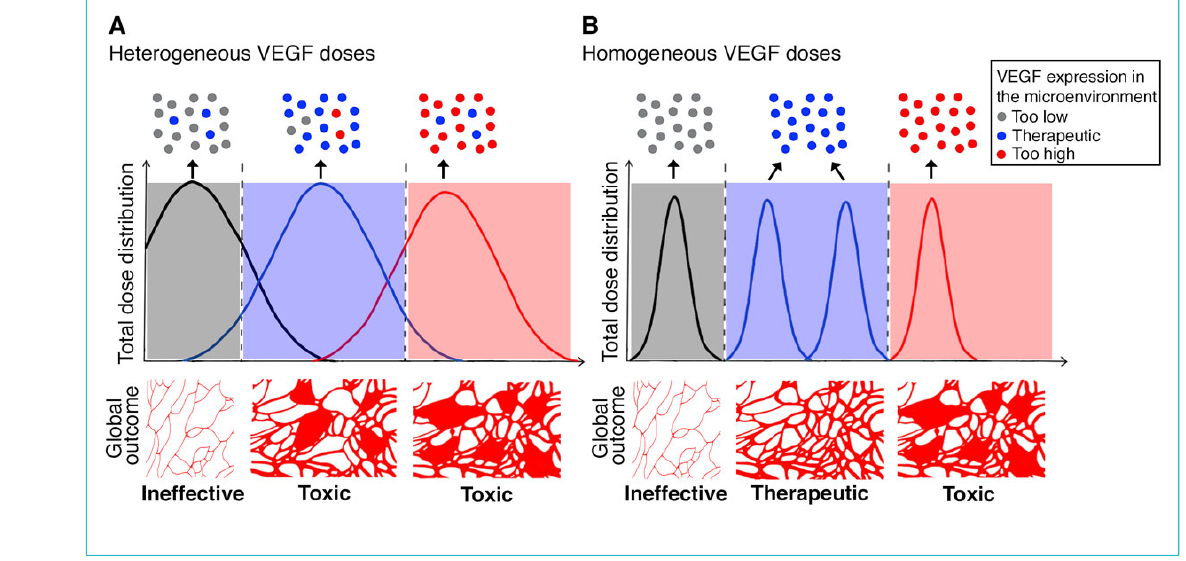
Figure 2: Functional outcomes of VEGF dose distribution in tissue. A. Heterogeneous dose distributions (e.g. by gene therapy vectors) lead to some hotspots of excessive expression that remain localised in the microenvironment around producing cells (red spots on upper pan- els) and lead to toxic effects. Reducing the total dose does not completely avoid toxic hotspots, even if therapeutic levels are achieved in some areas (blue spots), until the total dose is so low that mostly inefficient levels are achieved (grey spots), leading to a global outcome that goes from toxic to inefficient, apparently without a significant therapeutic window (lower panels). B. Homogeneous distribution of the total dose in the tissue allows consistent therapeutic levels to be achieved in the microenvironment around each expressing cell and unveils the thera- peutic window of VEGF